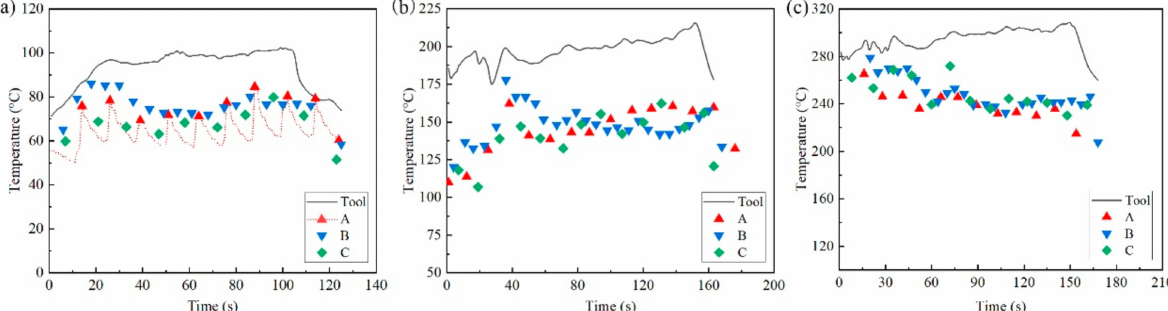
Figure 4. Real-time temperature of the tool head and sampling points A, B and C: ( a ) target temperature 100 ◦ C, ( b ) target temperature 200 ◦ C and ( c ) target temperature 300 ◦